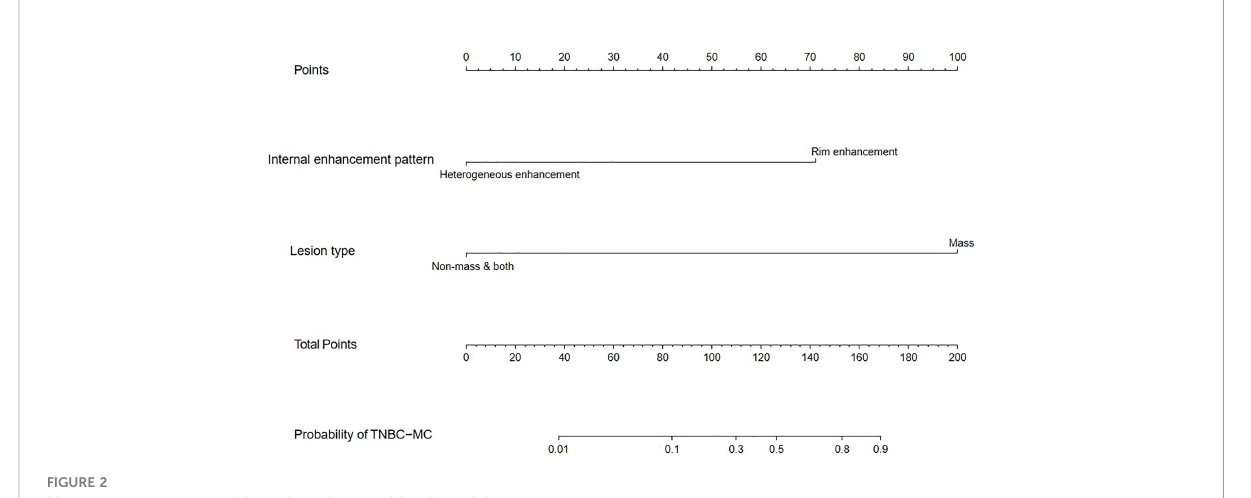
FIGURE 2 Nomogram constructed based on the combined model.